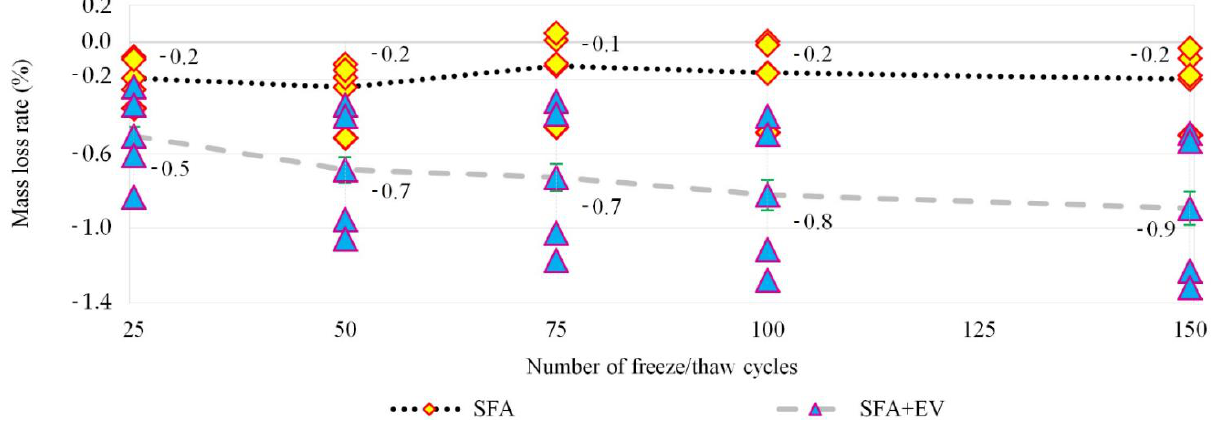
Figure 11. Mass loss of specimens during freeze/thaw cycles.